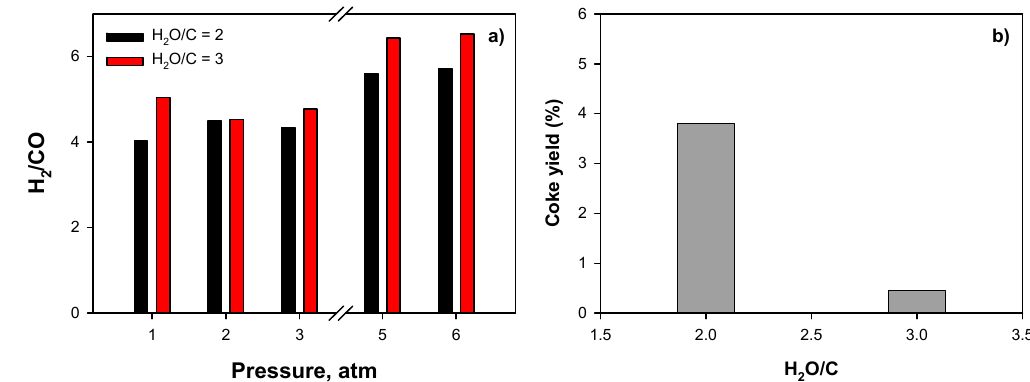
Figure 15. ( a ) H 2 /CO ratio as a function of pressure during steam reforming of AZ mixture on 5 Ni monolith at 720 °C; gas-phase feed composition: Solvent/H 2 O/N 2 = 0.7/4/95.3 for H 2 O/C = 2; solvent/H 2 O/N 2 = 0.7/6/93.3 for H 2 O/C = 3. ( b ) Coke yields as a function of the H 2 O/C ratio.